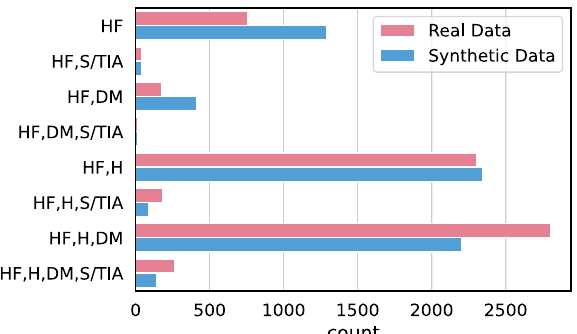
Fig. 9 Comorbidities for the real and synthetic atrial fi brilla- tion cohorts. We de fi ne the comorbidities for atrial fi brillation as